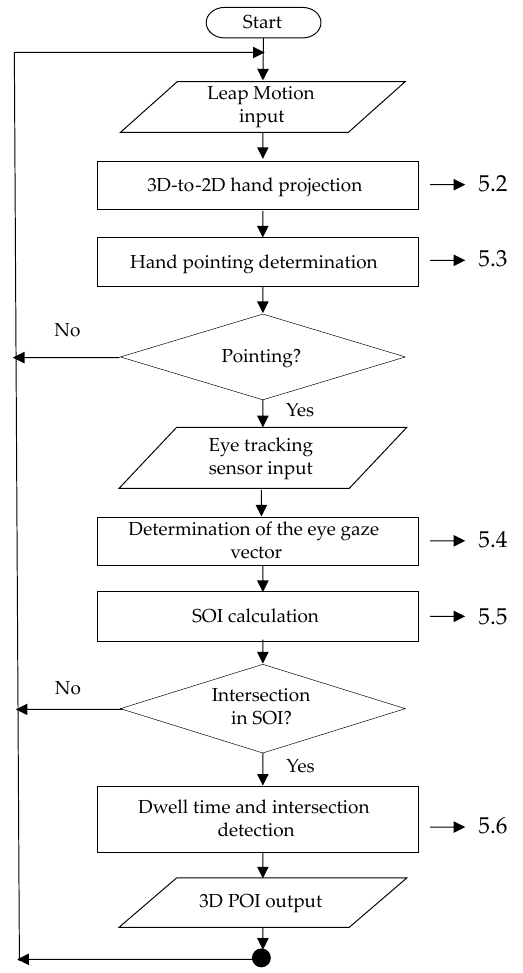
Figure 11. Flowchart of proposed